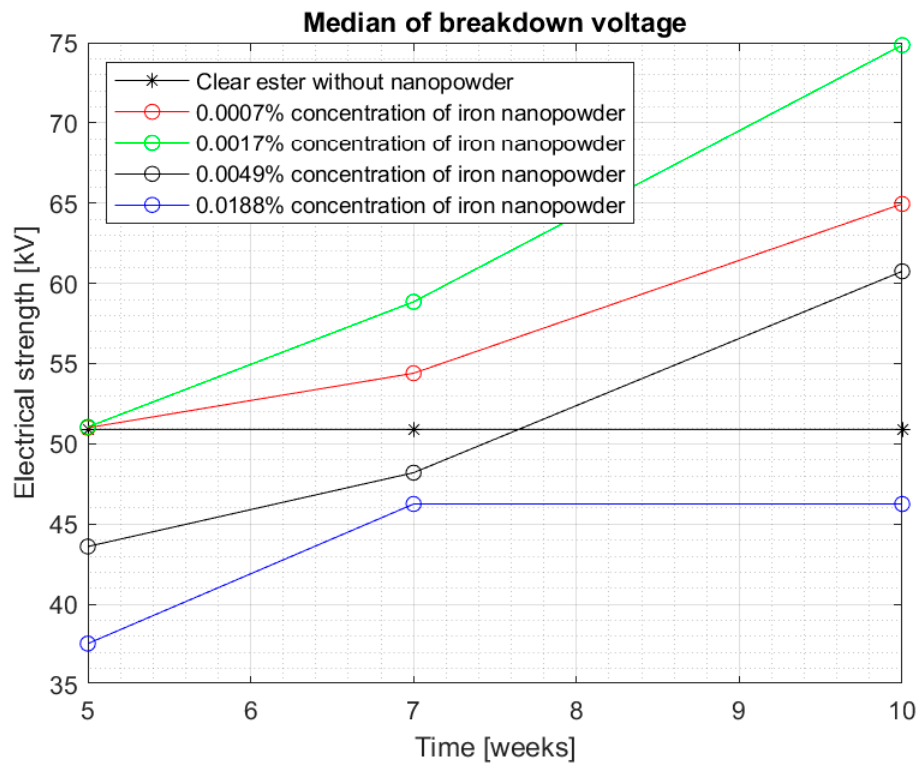
Figure 10. Median of all measurement results for each nanofluid from five to ten weeks mixing.